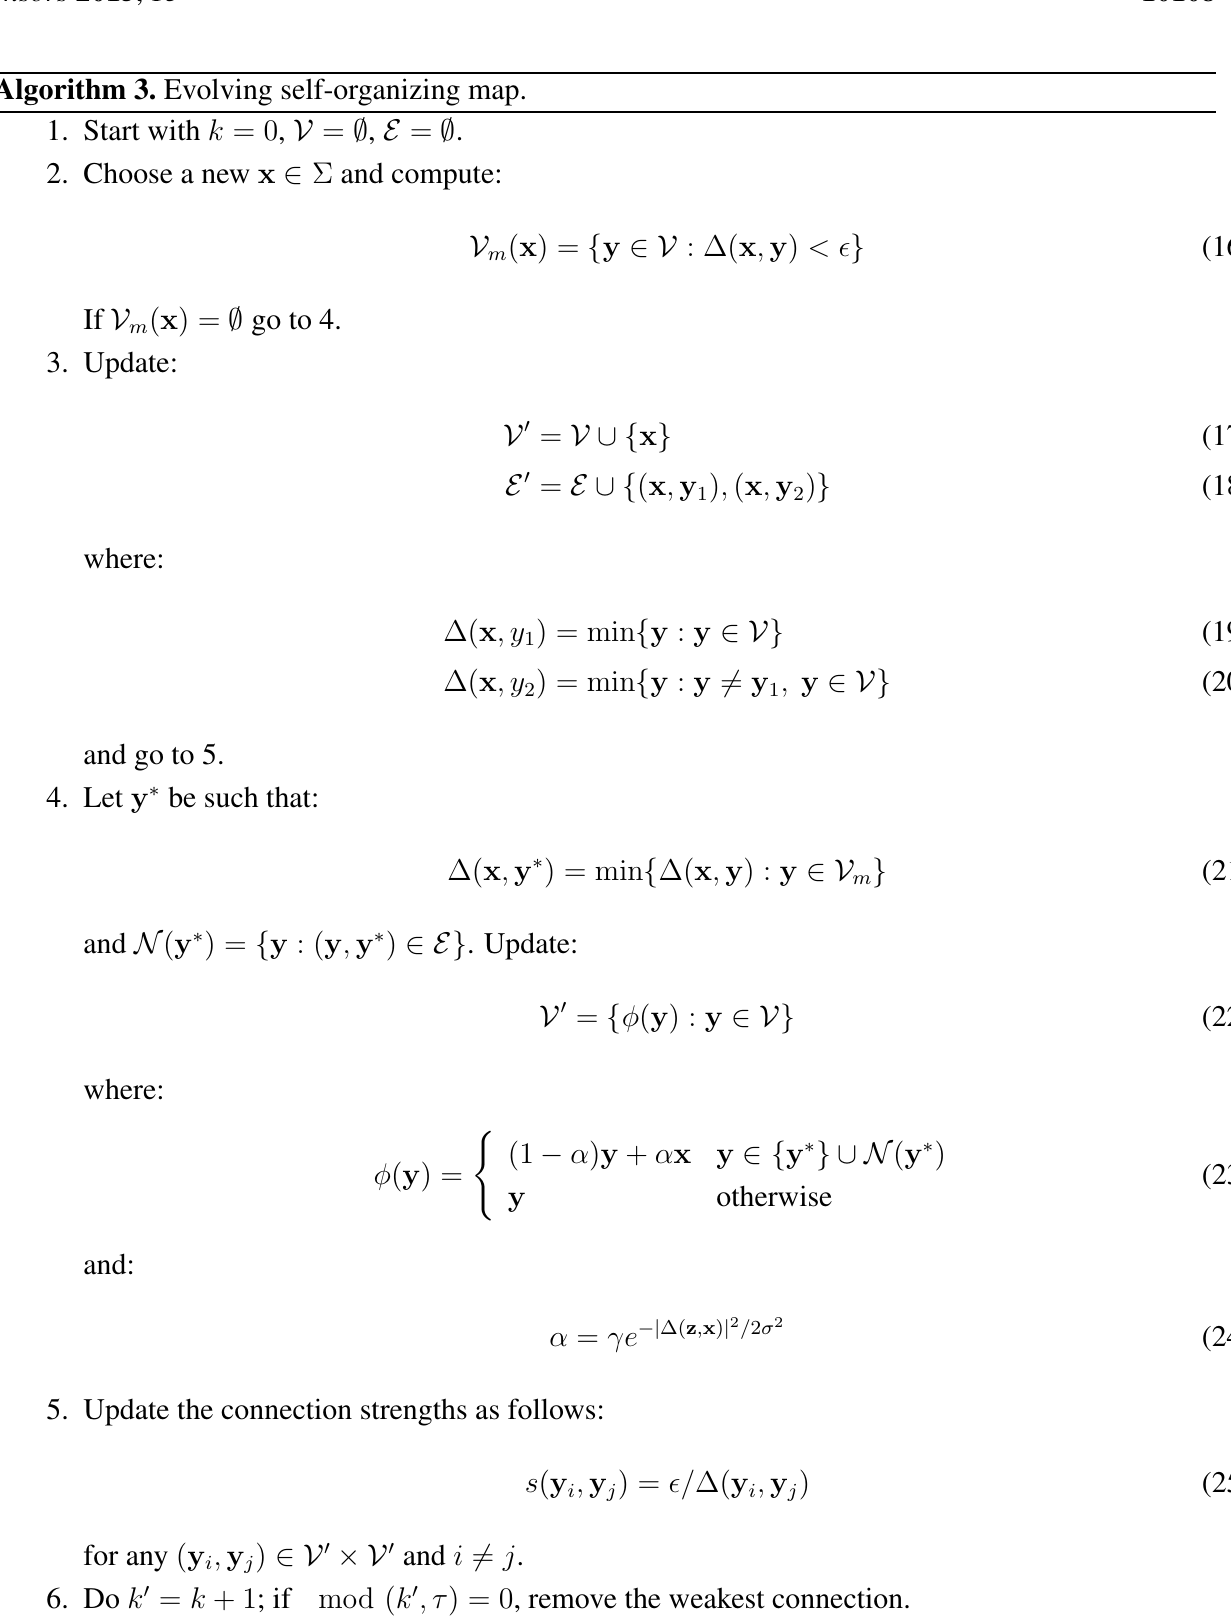
Algorithm 3. Evolving self-organizing